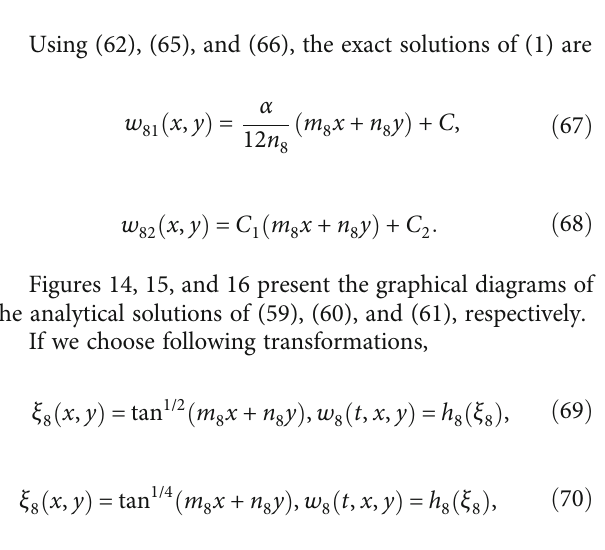
Figure 16: 3D complex plot of (61) for α = 1 and m